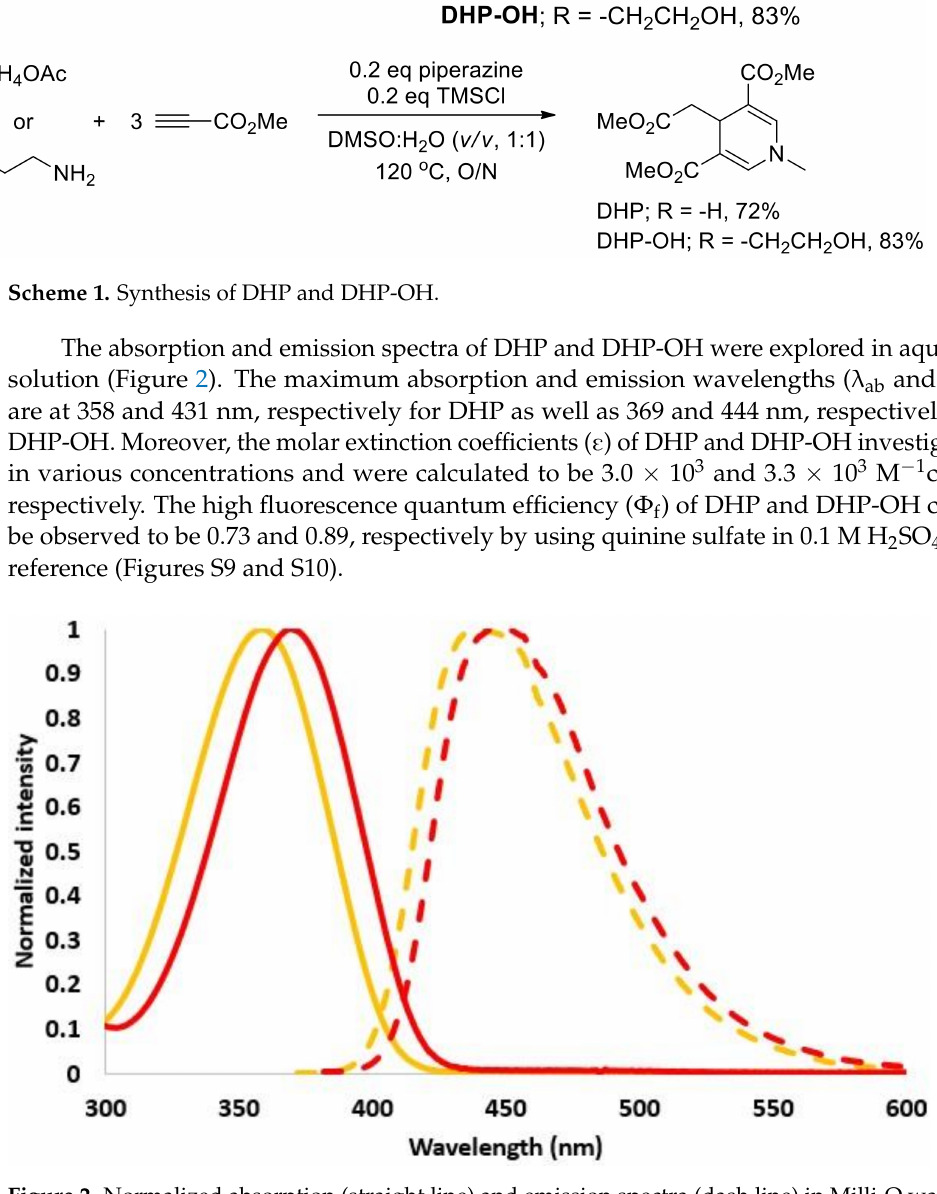
Figure 2. Normalized absorption (straight line) and emission spectra (dash line) in Milli-Q water of DHP (yellow) and DHP-OH